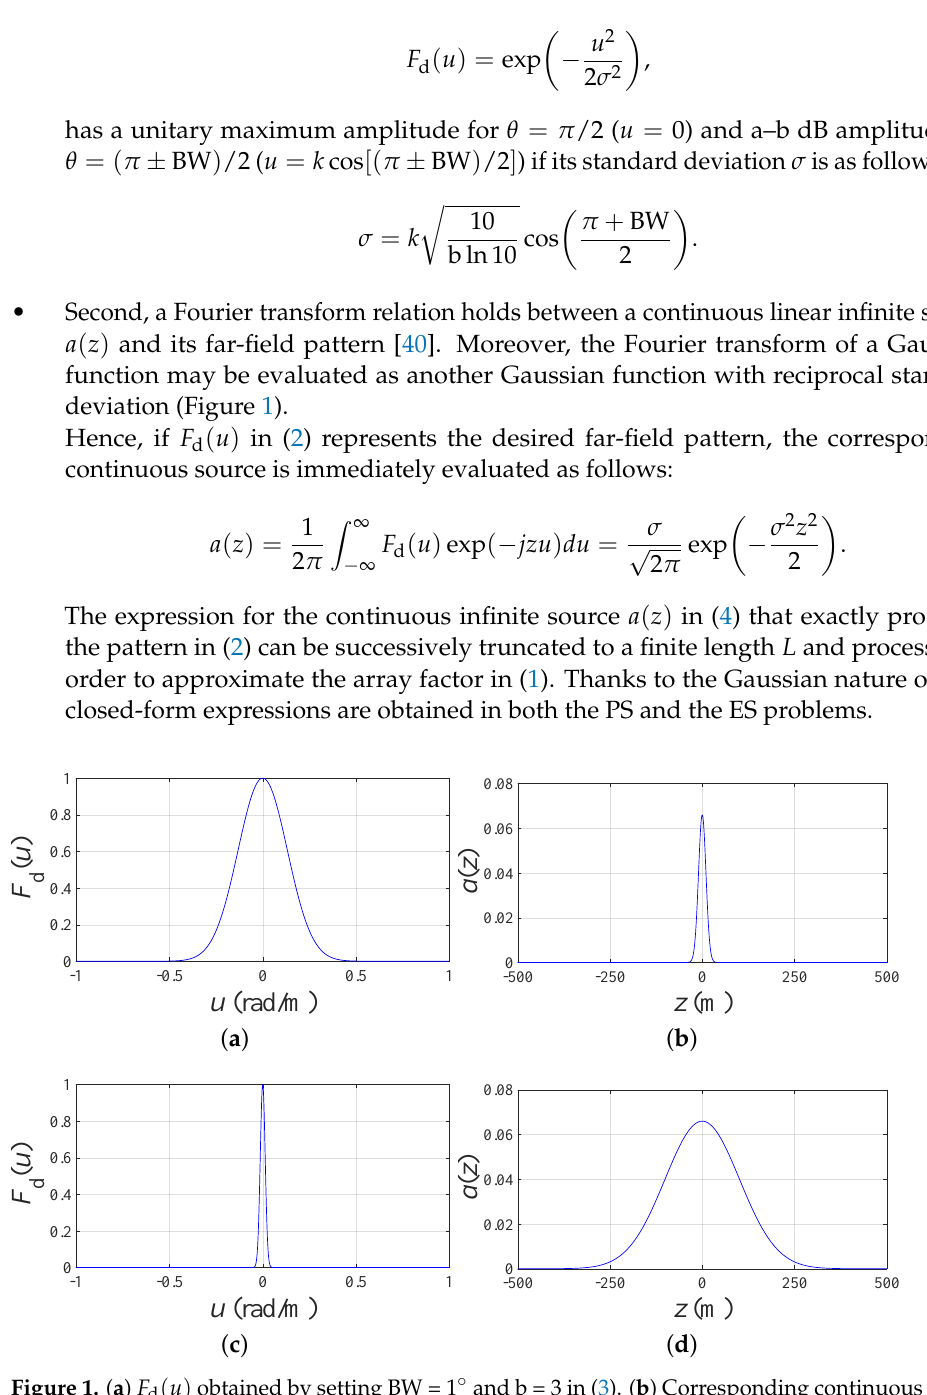
Figure 1. ( a ) F d ( u ) obtained by setting BW = 1 ◦ and b = 3 in (3). ( b ) Corresponding continuous source a ( z ) . ( c ) F d ( u ) obtained by setting BW = 0.1 ◦ and b = 3 in (3). ( d ) Corresponding continuous